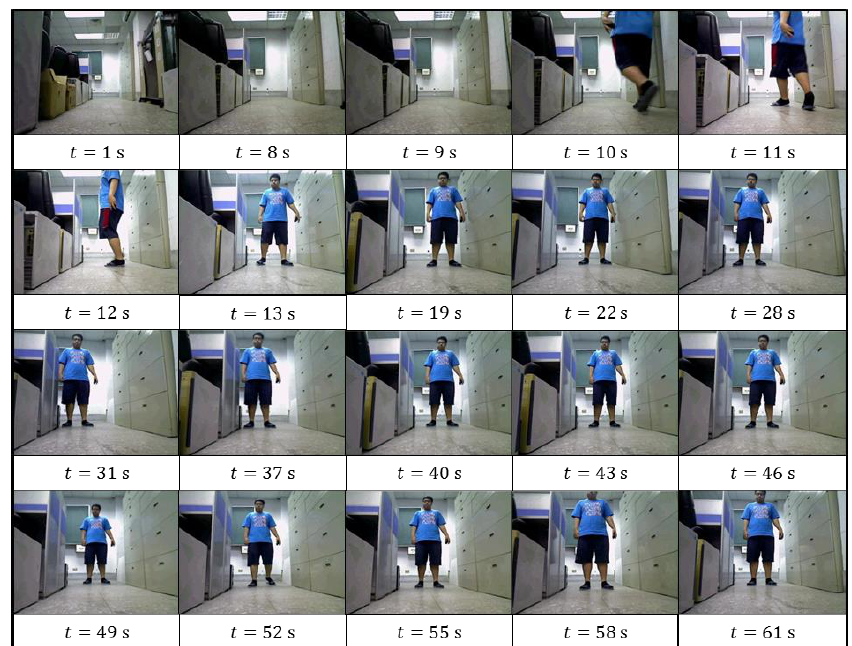
Figure 13. The recorded images of intruder recorded by robot.